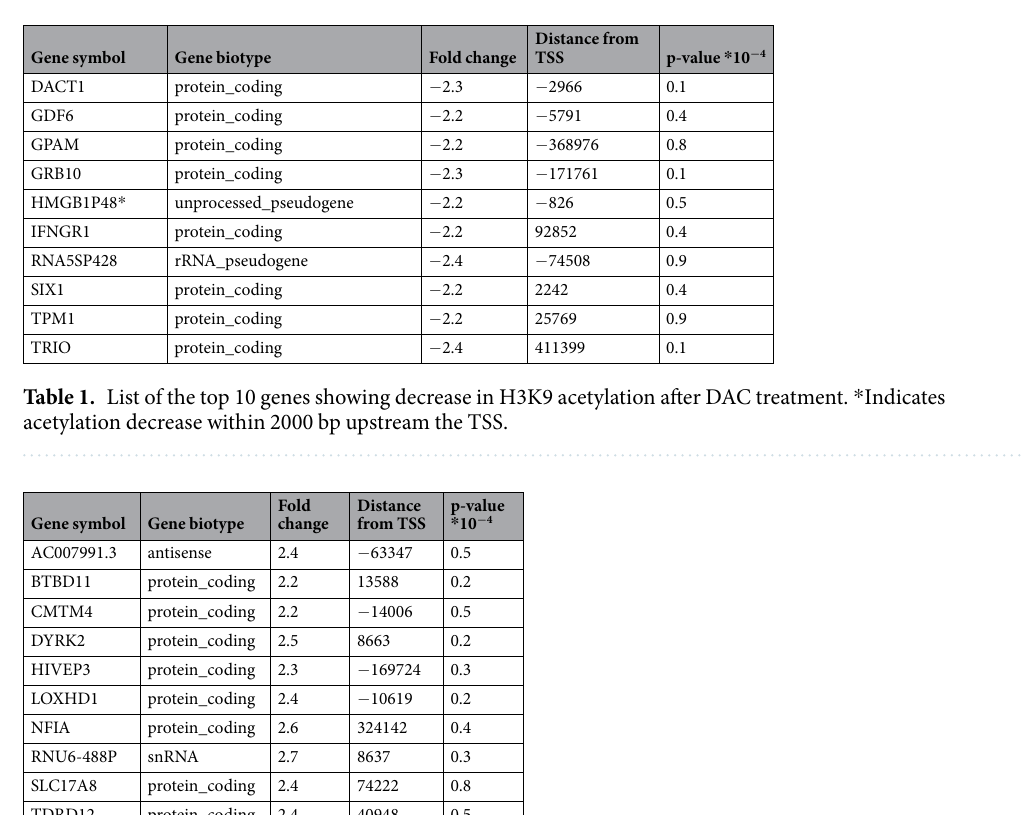
Figure 5. Top 5 genes modulated by DAC treatment. Overlay plots of control and DAC-treated cells showing the chromosomal locations of the peaks of acetylation decrease (upper panel) and acetylation increase (lower panel) of the top 5 genes. The gene map underneath each plot shows the distance from the start of the peak (indicated by the downward arrow) to the TSS (bent arrow). Gene maps are not drawn to scale. DT indicates DAC treatment and CT indicates control cells.